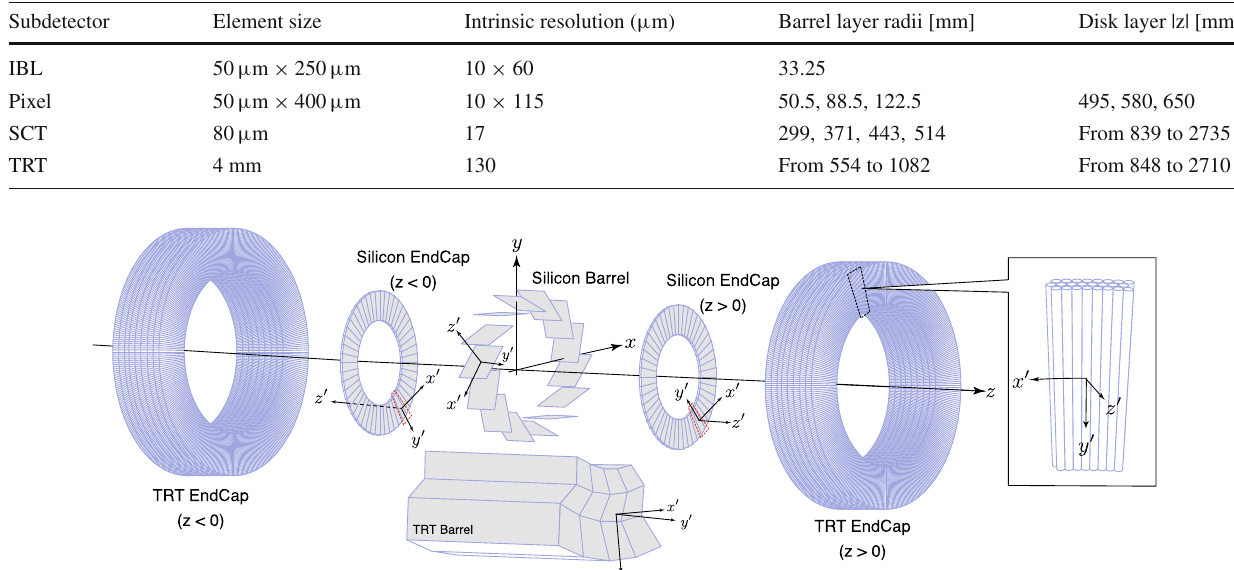
Fig. 2 Schematic representation of the ATLAS global reference frame ( x , y , z ) andthelocalreferenceframe ofeachcomponent oftheID. The Pixel, IBL, and SCT modules are grouped in the ‘Silicon’ category. For each component, the local- x axis points along the most sensitive direc- tion; the local- z axis points away of the ATLAS centre; and the local- y